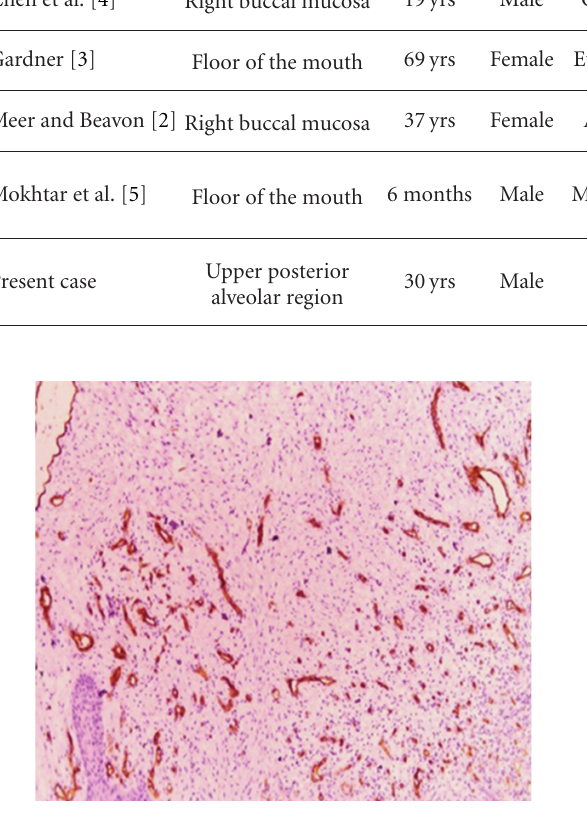
Figure 5: The endothelial cells of the blood vessels stained strongly for CD34